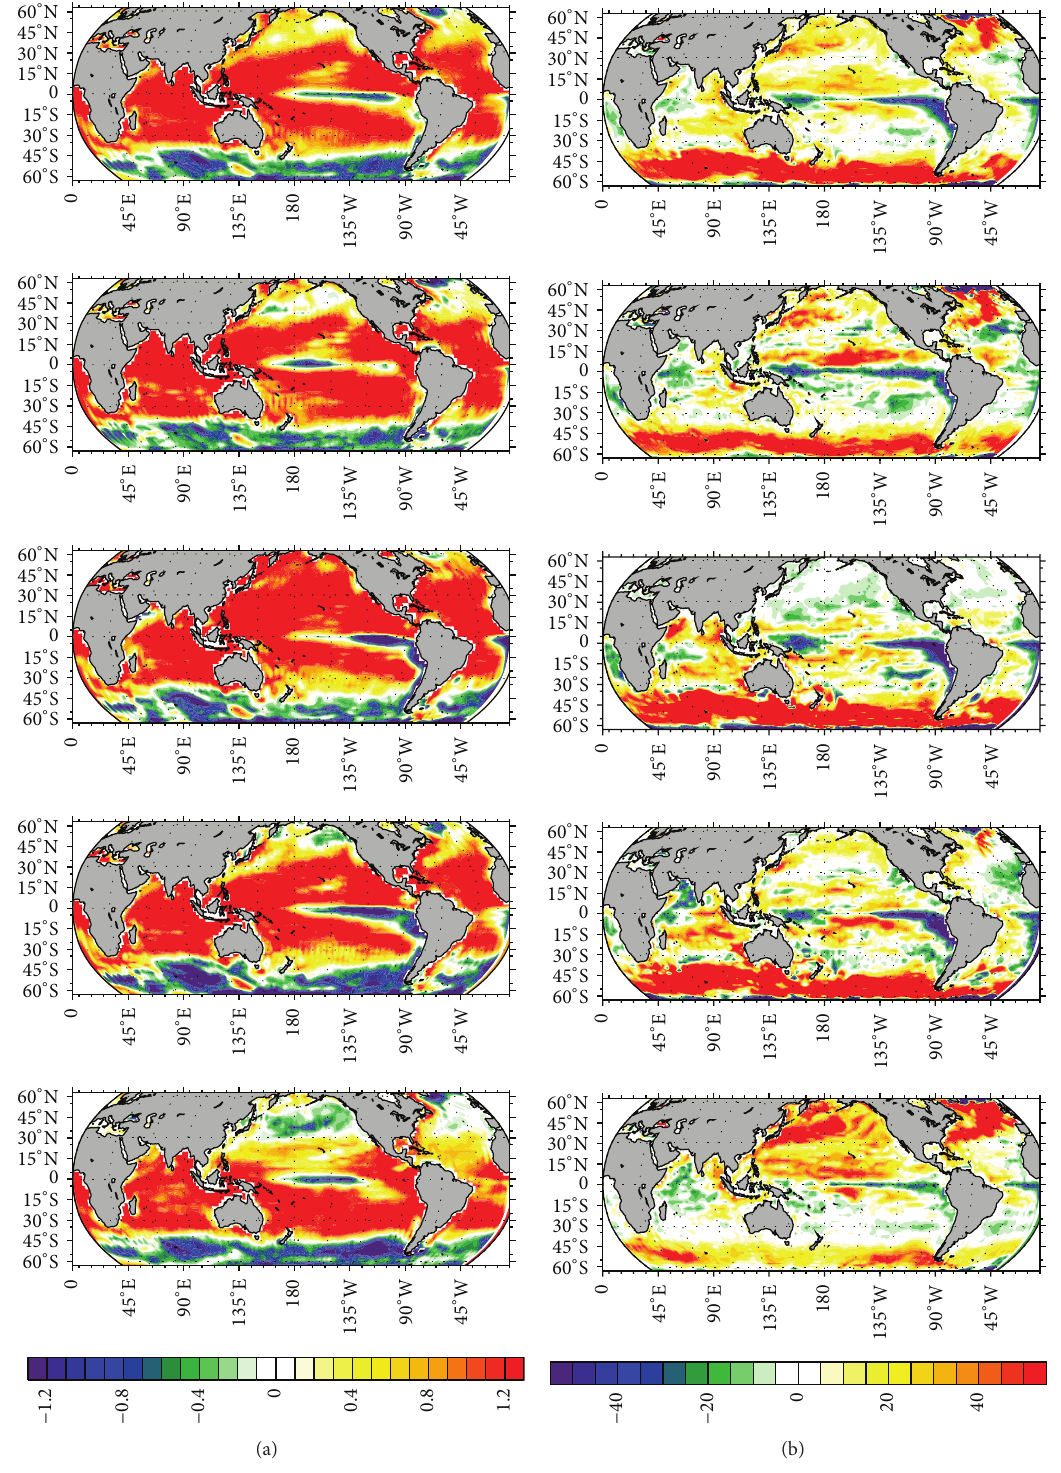
Figure 4: Changes in mixed layer temperature in ∘ C (a) and changes in mixed layer depth in m (b) due to the inclusion of CSF into HYCOM. Plots from top to bottom, in order, respectively show the annual-mean, spring-mean (Mar ∼ May), summer-mean (Jun ∼ Aug), fall-mean (Sep ∼ Nov), and winter-mean (Dec ∼ Feb)